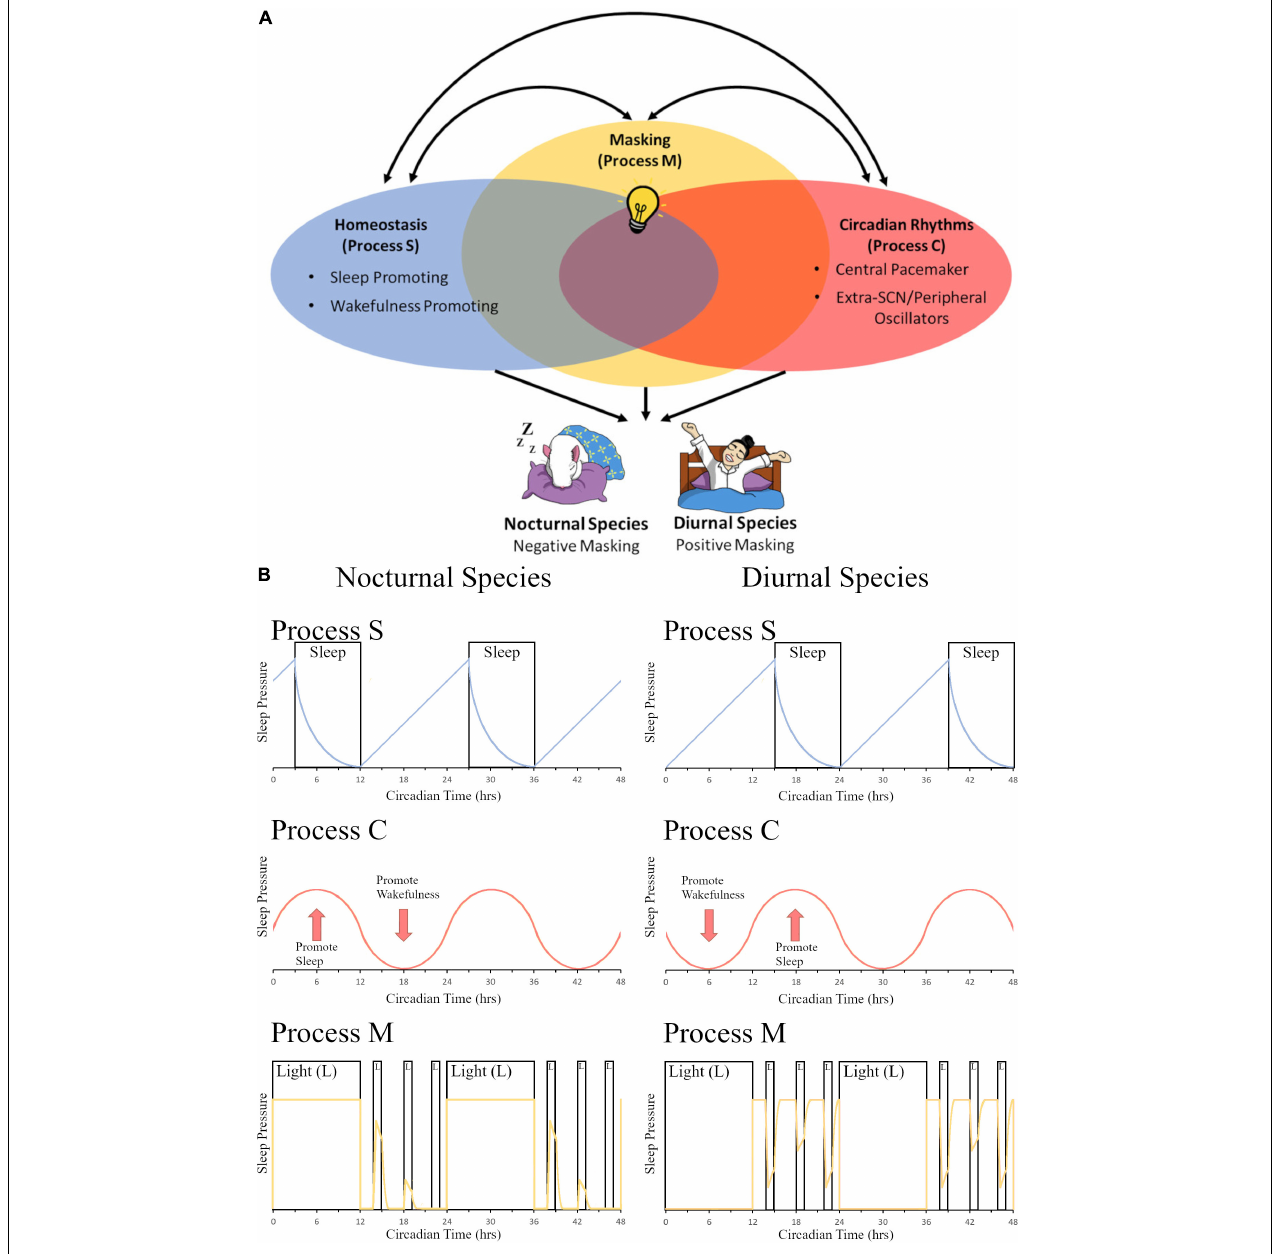
FIGURE 1 | The contribution of light-induced masking to the two-process sleep regulation model. (A) In the two-model system of sleep regulation, sleep is driven by the homeostatic process (Process S, Blue Oval) and the circadian process (Process C, Red Oval). Anatomically, these regions can be divided into sleep or wake promoting regions in Process S and Central pacemaker (SCN) or Extra-SCN/peripheral Oscillators in Process C. Here we also propose a third component to the model, masking (Process M, Yellow Oval). In this depiction, the systems share some overlap between all three processes as extra-SCN oscillators, regions of the brain that promote wakefulness/sleep, and masking activation of the brain can all occur within the same region. Additionally, different stimuli that govern sleep and circadian rhythms, such as light (depicted as a light bulb), can induce opposing effects in nocturnal versus diurnal species. Light for a nocturnal rodent induces sleep, causing a negative masking response in activity; while for a diurnal human, light increases arousal and produces a positive masking effect on activity. (B) A model of changes in sleep pressure are depicted for nocturnal species (left panel) and diurnal species (right panel). Process S represents the homeostatic system and how sleep pressure builds at night for nocturnal organisms and during the day for diurnal organisms, with sleep pressure dissipation when the organism is sleeping. Sleep pressure peaks at opposite times of day for nocturnal vs. diurnal organisms. Process C represents the circadian system. Sleep pressure peaks at the beginning of the day for nocturnal organisms, whereas it peaks at the beginning of the night for diurnal organisms. Process M represents the masking system. The yellow line depicts sleep pressure, which peaks during the day for nocturnal organisms, and at night for diurnal organisms; light at night is capable of increasing sleep pressure in nocturnal organisms, whereas it is capable of decreasing sleep pressure in diurnal organisms. Panel (B) (Process S and Process C) is redrawn from Borbély (1982) and Borbély et al. (2016). Panel (B) (Process M) is modeled based on masking data from Shuboni et al. (2015).